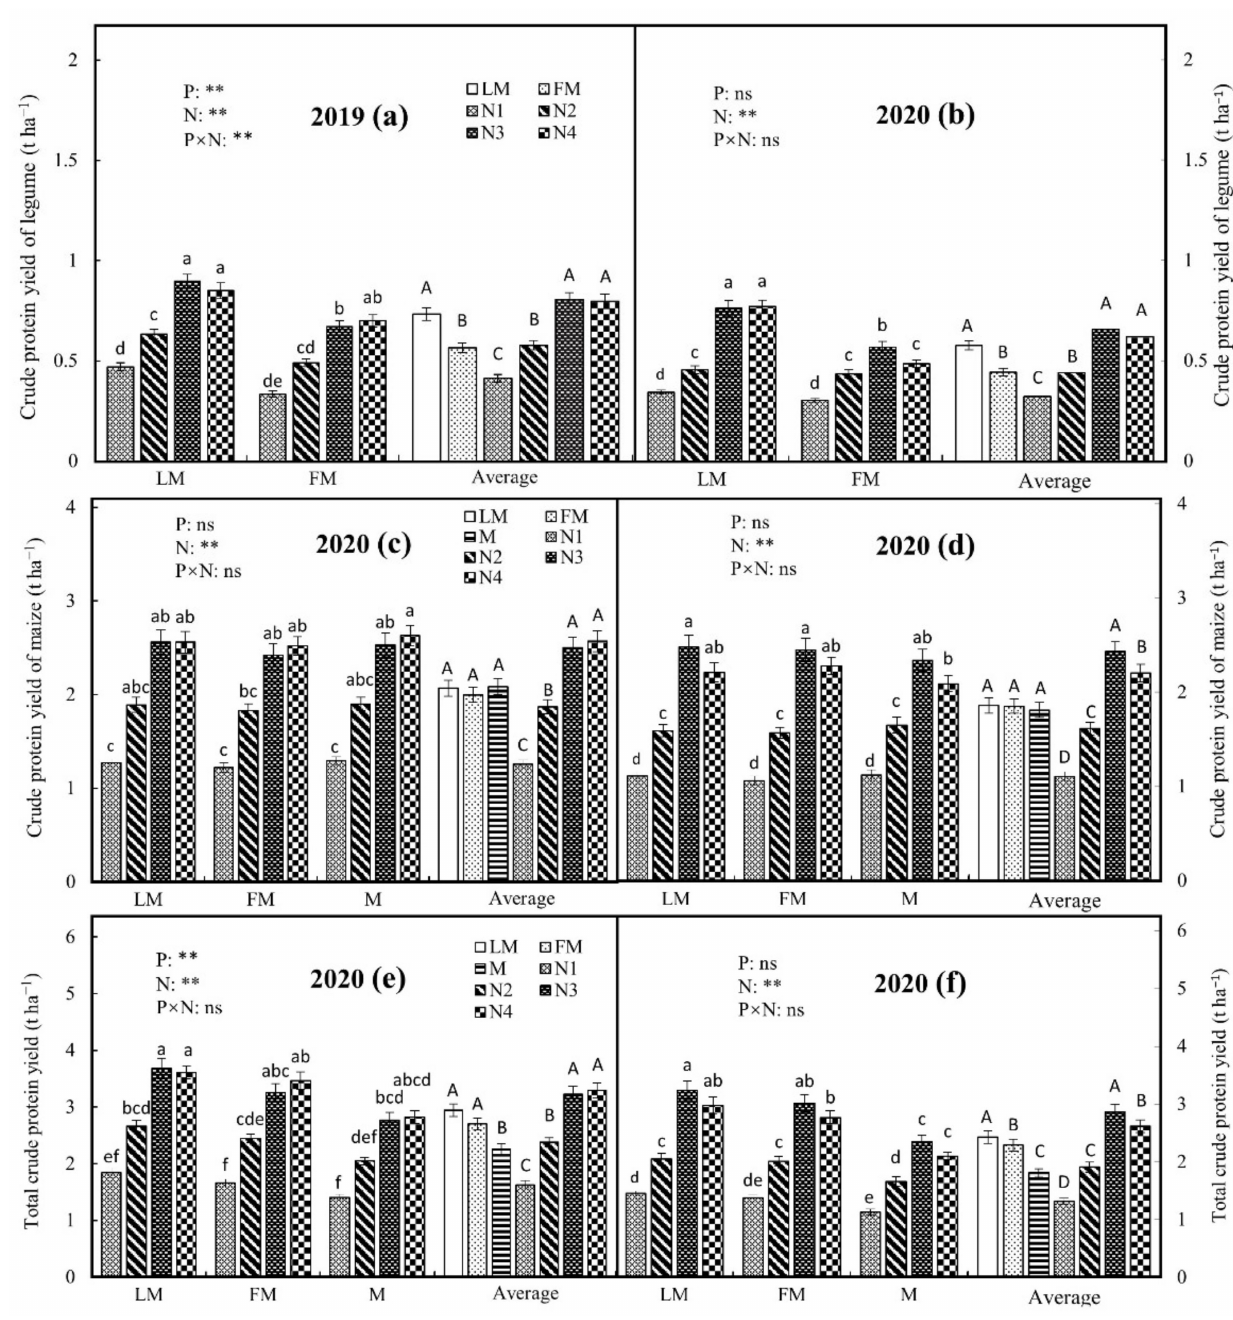
Figure 5. Crude protein yield of legume, maize, and intercropping systems under different treatments in 2019 and 2020. Note: ( a ), fresh yield of legume in 2019; ( b ), fresh yield of legume in 2020; ( c ), fresh yield of maize in 2019; ( d ), fresh yield of maize in 2020; ( e ), total fresh biomass yield in 2019; ( f ), total fresh biomass yield in 2020. M, silage maize monoculture; FM, intercropping of fodder soybean and silage maize; LM, intercropping of Dolichos lablab and silage maize; N1, 0 kg ha − 1 N; N2, 120 kg ha − 1 N; N3, 240 kg ha − 1 N; N4, 360 kg ha − 1 N. P, N, and P × N represent planting patterns, N application, and interaction between them, respectively; ** p < 0.01; ns, no significant difference. Different lowercase letters in the same series indicate significant differences among different treatments for the same forage ( p < 0.05). The different uppercase letters in the same series indicate significant differences among different levels of factors for the same forage ( p <